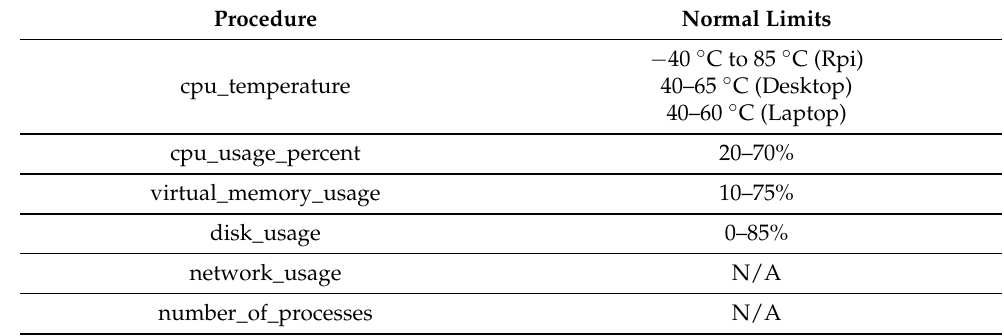
Table 4. Procedures to monitor edge performance.